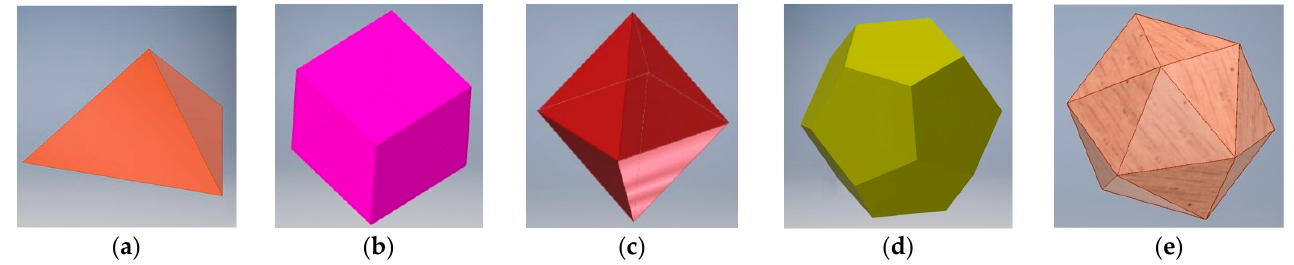
Figure 10. Tilt sensor in a form of pentagonal prism: ( a ) perspective view; ( b ) inside chamber; ( c ) establishing of electric contact (short-circuiting of the lower and the two side electrodes).